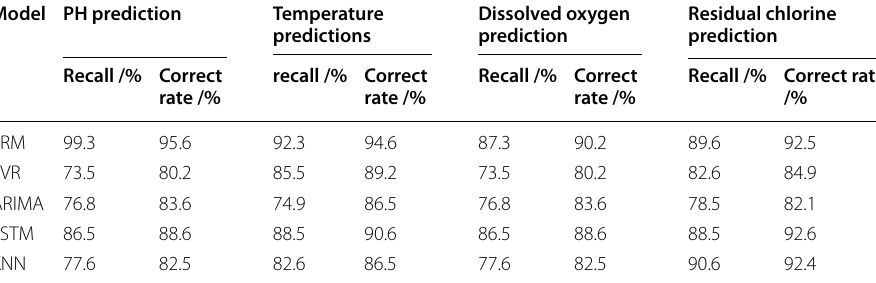
Table 1 Comparison of LRM model and contrastive model Model PH prediction Temperature